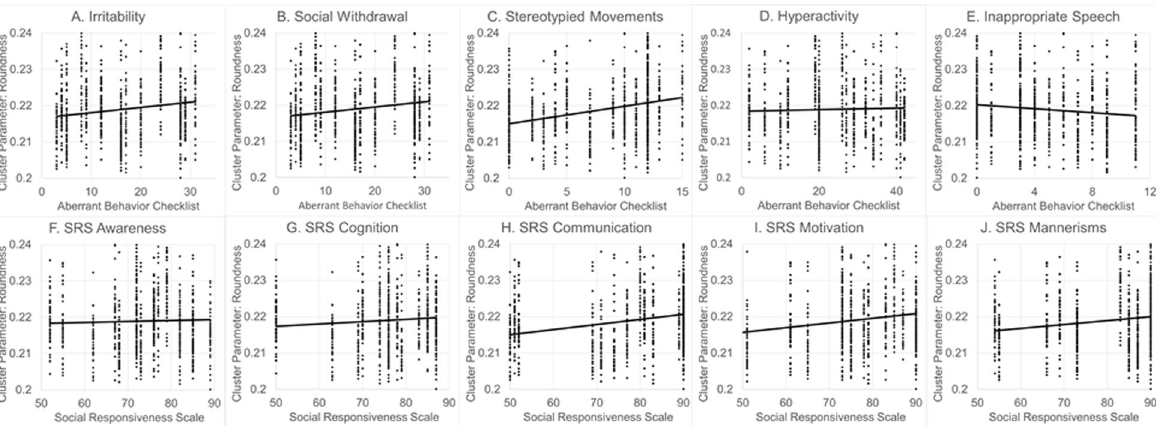
Fig. 6 The relationship between ASD symptoms and behaviors for mitochondrial cluster roundness. Both ( B ) social withdrawal and ( C ) stereotyped movements on the aberrant behavior checklist (ABC) were signi fi cantly worse with increased mitochondrial cluster roundness.